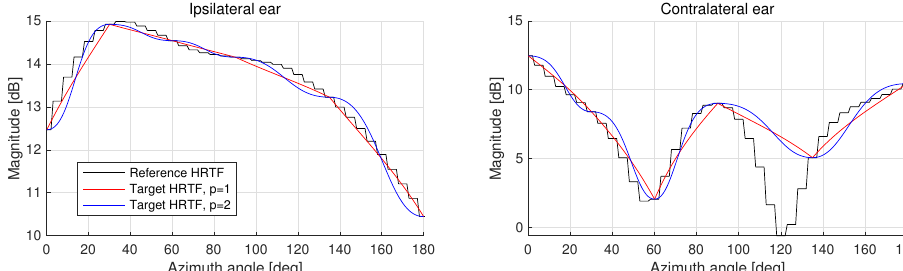
Figure 4. Approximation results of the HRTF magnitude in Equation (4) calculated at the 5th subband of the 64-band QMF operating on a 22.2-channel virtual loudspeaker layout. Loudspeakers are located at azimuth angles 0 ◦ , ± 30 ◦ , ± 60 ◦ , ± 90 ◦ , ± 135 ◦ , and 180 ◦ in the horizontal